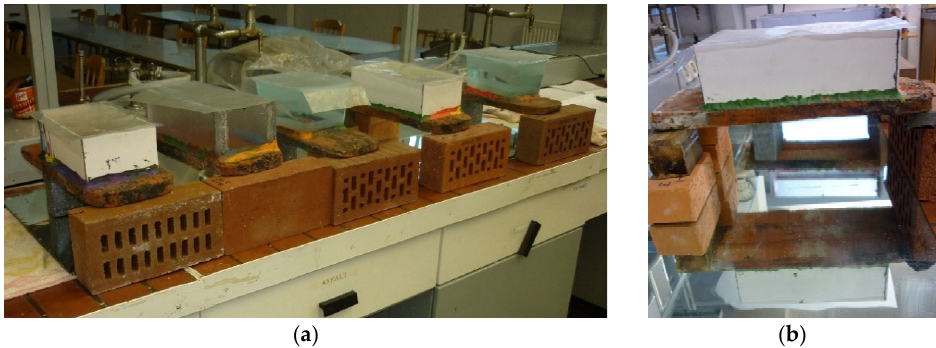
Figure 9. Roof tiles during the impermeability test: ( a ) general view; ( b ) view of the underside of tile.